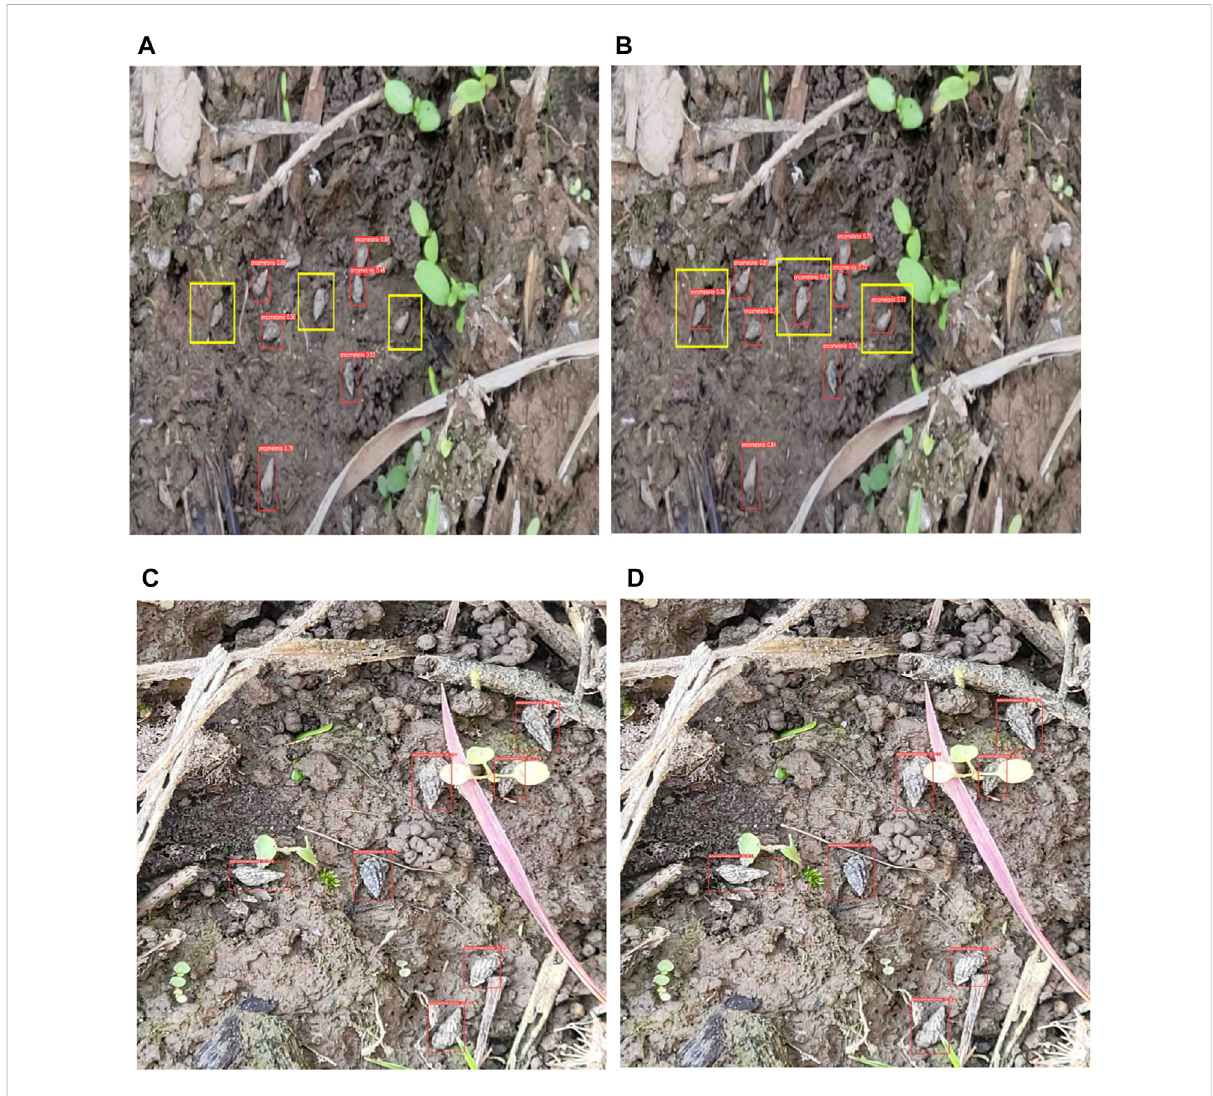
FIGURE 10 Theresult ofobjectdetection. (A,C) ThepredictionoftheYOLOv5s; (B,D) Theprediction oftheYOLOv5-ECA-vfnet; Theredrectangularboxes are the probability values of the algorithms to identify the pictures containing the snails, and the three yellow boxes are snails that YOLOv5s cannot detect in (A) . The improved algorithm can detect the snails in (B) . (C,D) are different in the predicted probability